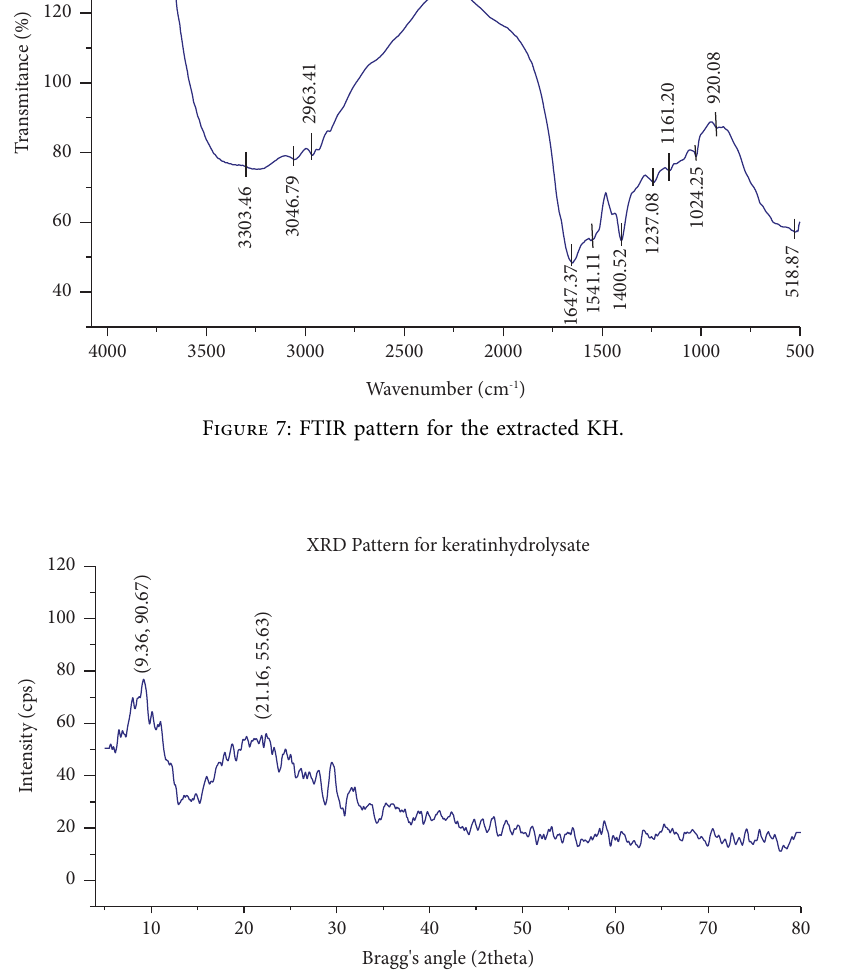
Figure 8: XRD analysis pattern of keratin hydrolysate.